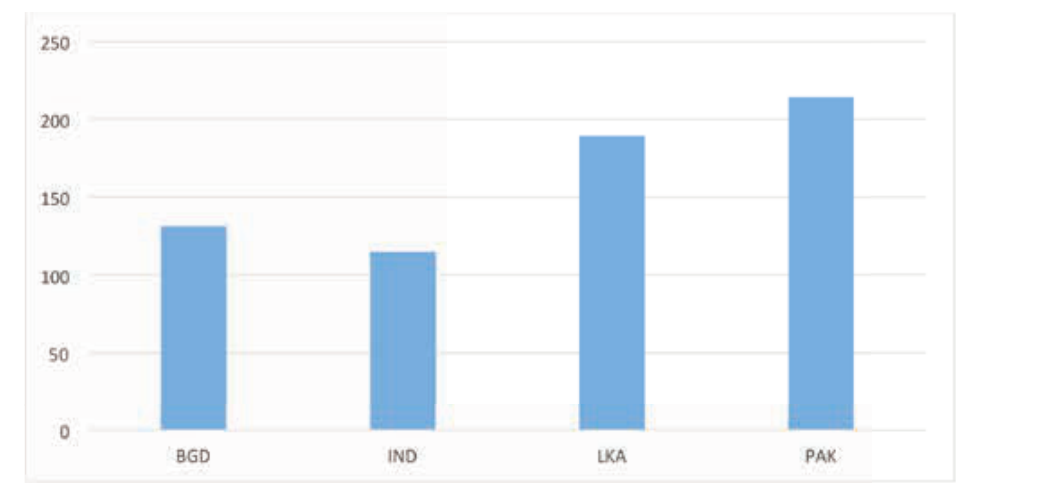
Figure 2: Sum of Inflation by